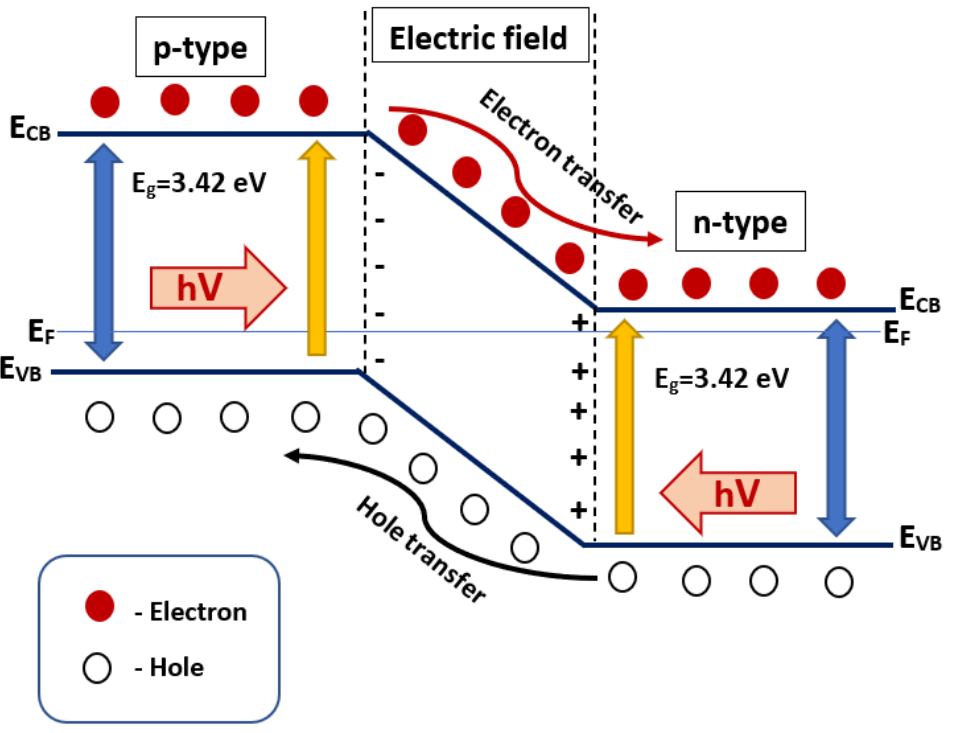
Figure 10. Schematic of p-n heterojunctions illustrating the energy band condition and separation of electron–hole pair.